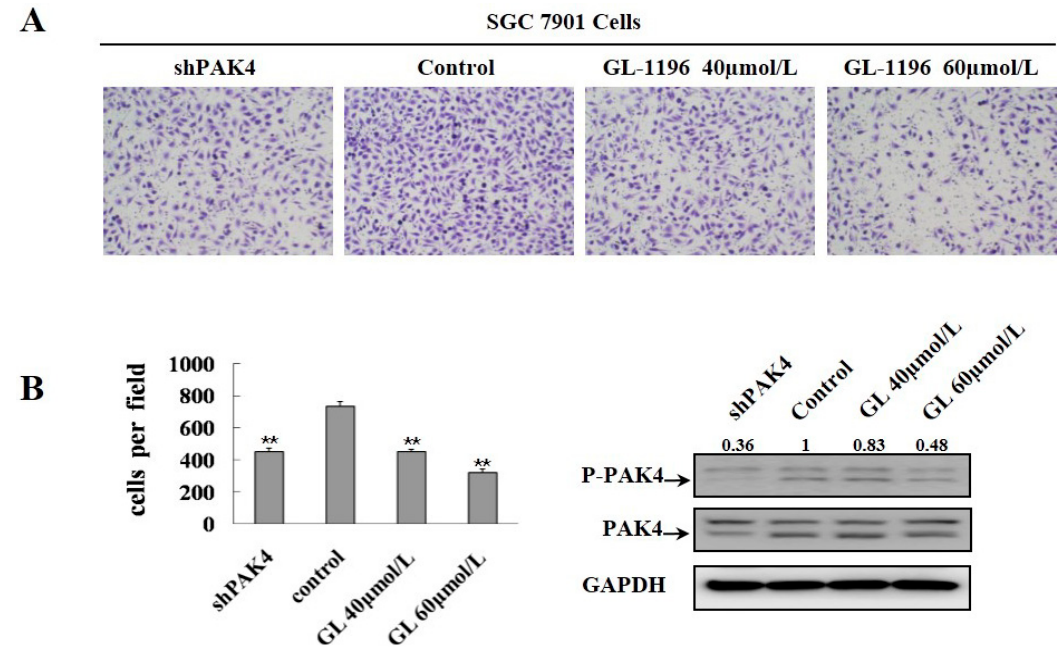
Figure 5. GL-1196 treatment showed the similar inhibitory effect on cell invasion by PAK4 knockdown. ( A ) the invasive ability of SGC7901 treated with GL-1196 and in which PAK4 knockdown was evaluated by chemotaxis chamber matrigel invasion assay. The magnification is 100×, and the number of invading cells is shown as bar diagram ± SEM ( B left), ** p < 0.01. Western blot analysis shows the protein level of PAK4 in cells ( B right).